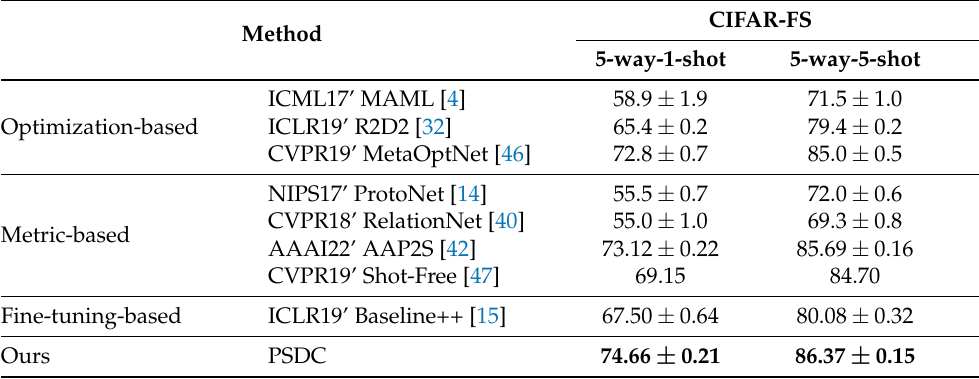
5-way-1-shot and5-way-5-shot classification accuracy (%) on CIFAR-FS with 95% confidence